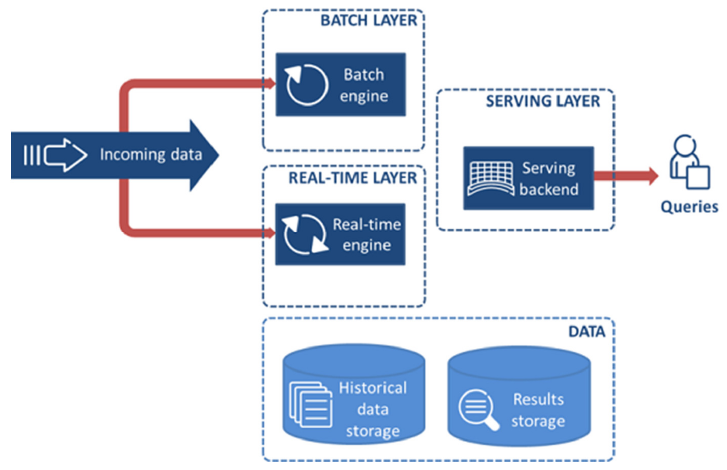
Figure 1. Lambda architecture (www.ericsson.com).